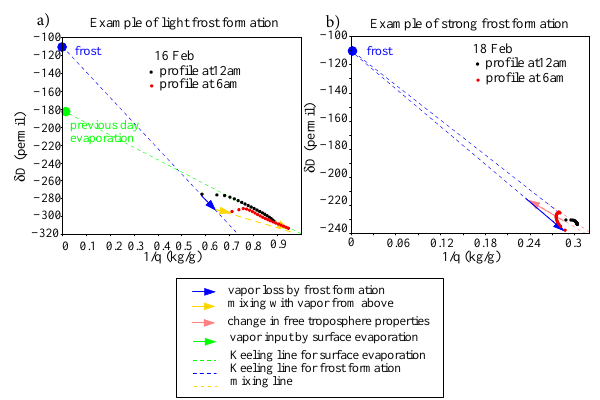
Fig. 11. As in Fig. 10 but for profile mixing line evolution during the formation of frost. (a) Light frost formation leads to a slight curvature in the data. (b) The case of strong frost shows the profile approaching the frost mixing line. The origin of high uncertainty in δ D F is seen graphically as the sensitivity in estimating the intercept on the left axis from regression when the data is clustered on the right side of the